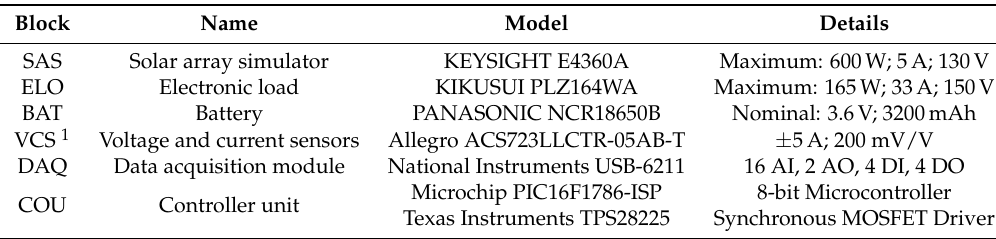
Figure 4. Block diagrams of the test setups. Table 4. Materials and equipment